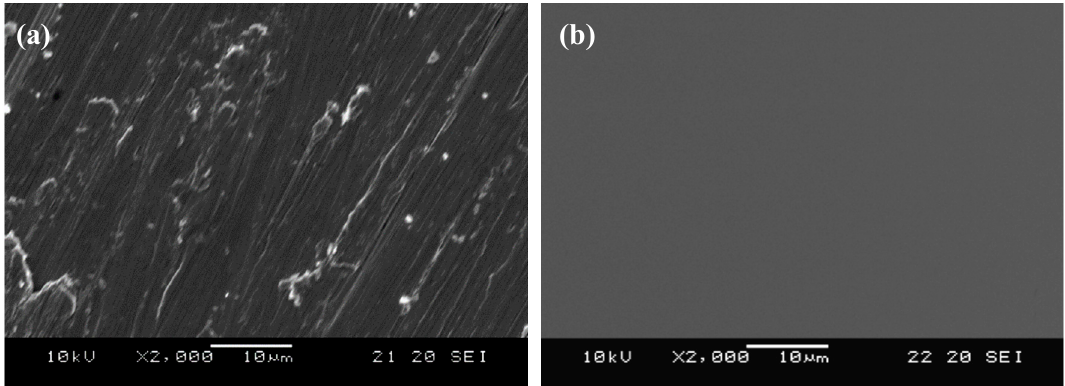
Figure 2. Surface morphologies of ( a ) un-modified and ( b ) hexamethyldisilazane (HMDSZ)-plasma treated (at 20 W for 20 min) for 304 stainless steel specimens.